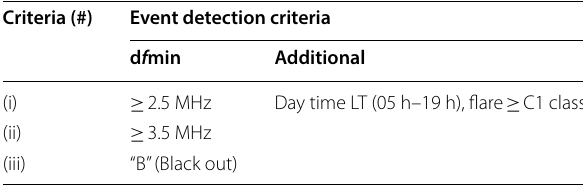
Table 1 Event detection criteria for SWF duration analysis Criteria (#)